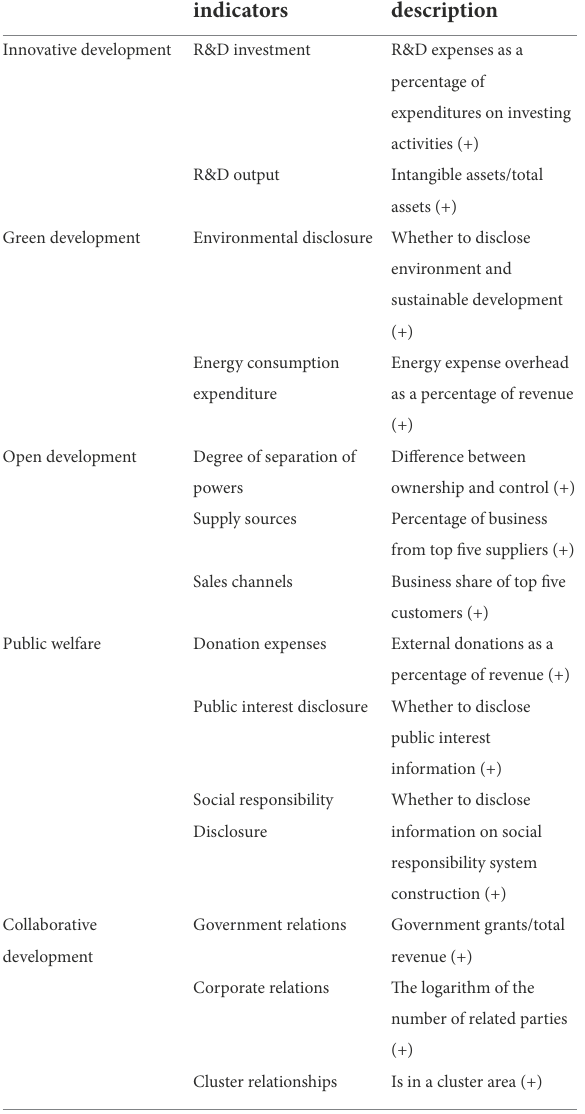
TABLE 1 High-quality development evaluation index